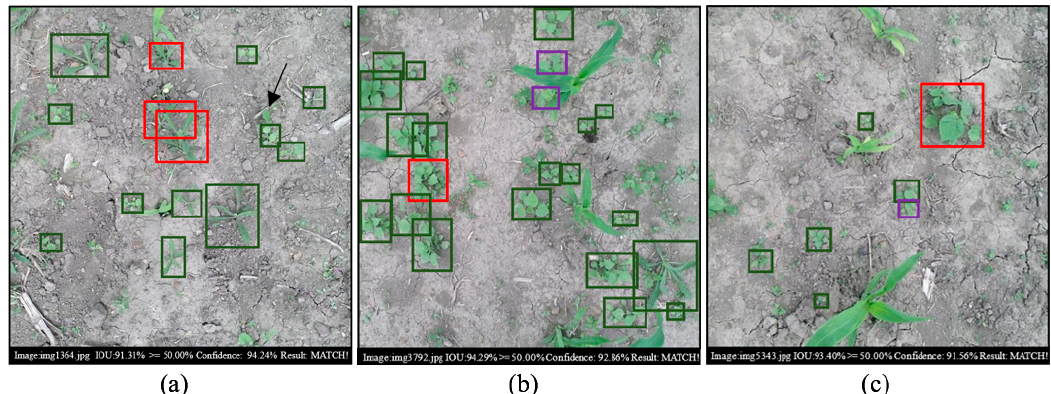
Figure 15. ( a – c ) show the different conditions in which weeds are shaded. The green boxes represent correctly identified weeds. The red boxes represent the recognition of several weeds as one weed. The purple boxes indicate that the network identified only part of the weeds. The black arrow indicates a weed that was not detected due to occlusion.